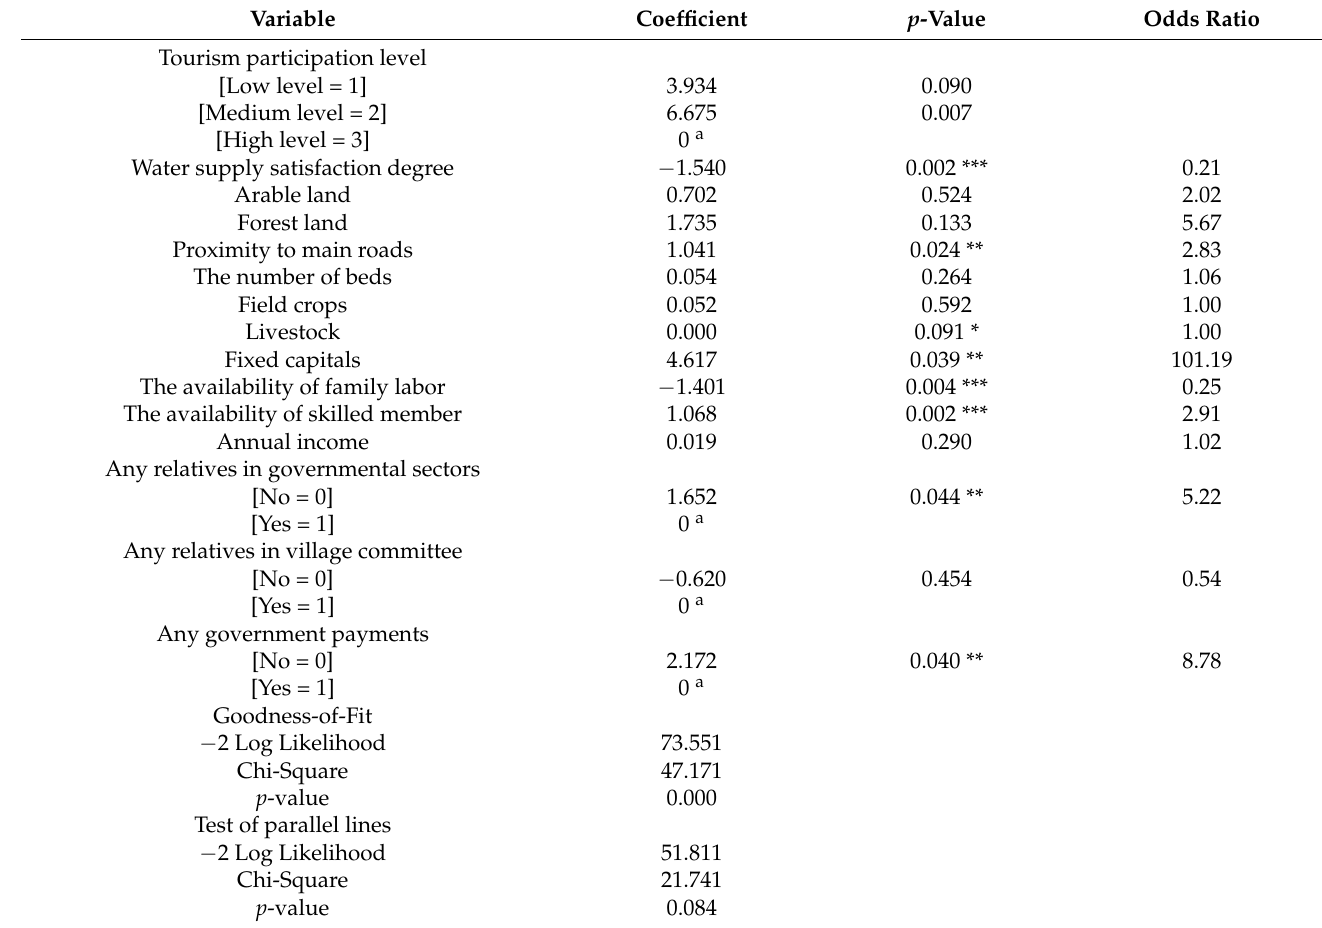
Table 4. Results of the ordinal logistic regression model on tourism participation